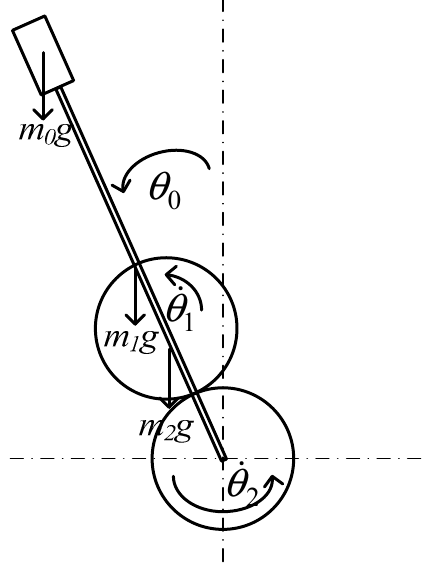
Figure 1. The structure of a planetary train-type inverted pendulum.